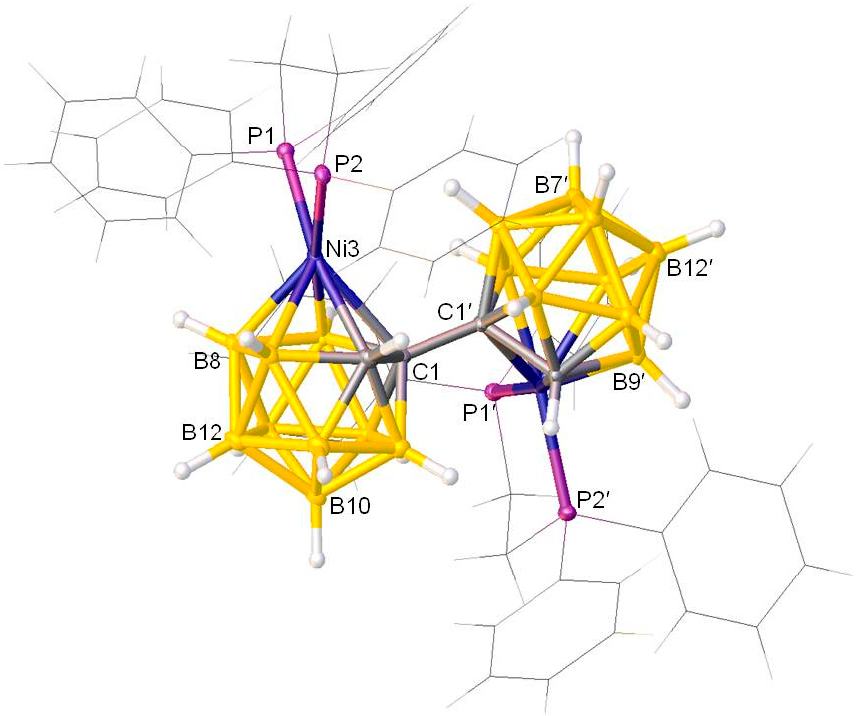
Figure 3. A perspective view of rac -[1-(1 ′ -3 ′ -(dppe)-3 ′ ,1 ′ ,2 ′ - closo -NiC 2 B 9 H 10 )-3-(dppe)-3,1,2- closo - NiC 2 B 9 H 10 ] ( 3 ) (all phenyls and the –CH 2 –CH 2 – bridge of dppe are in wireframe for clarity). Atoms with dashed suffixes are generated by the symmetry operation 1 − x, y, 0.5 − z.